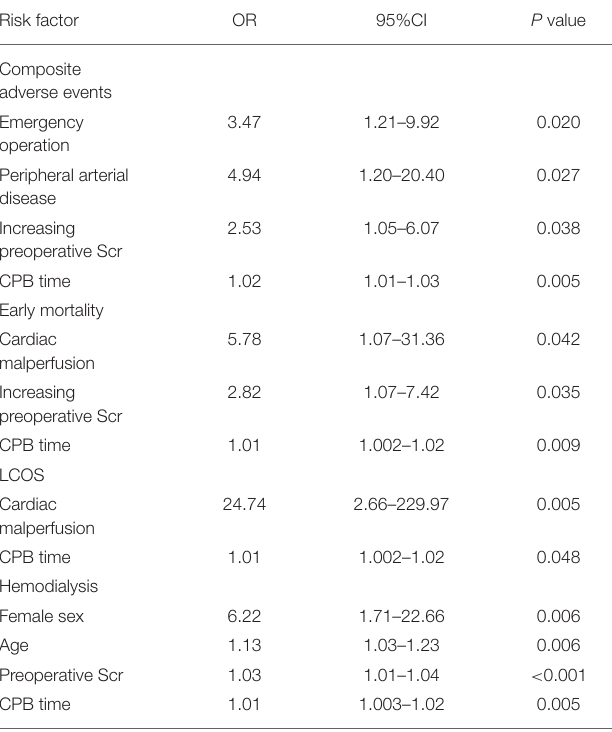
TABLE 4 | Multivariate logistic regression analysis for early clinical